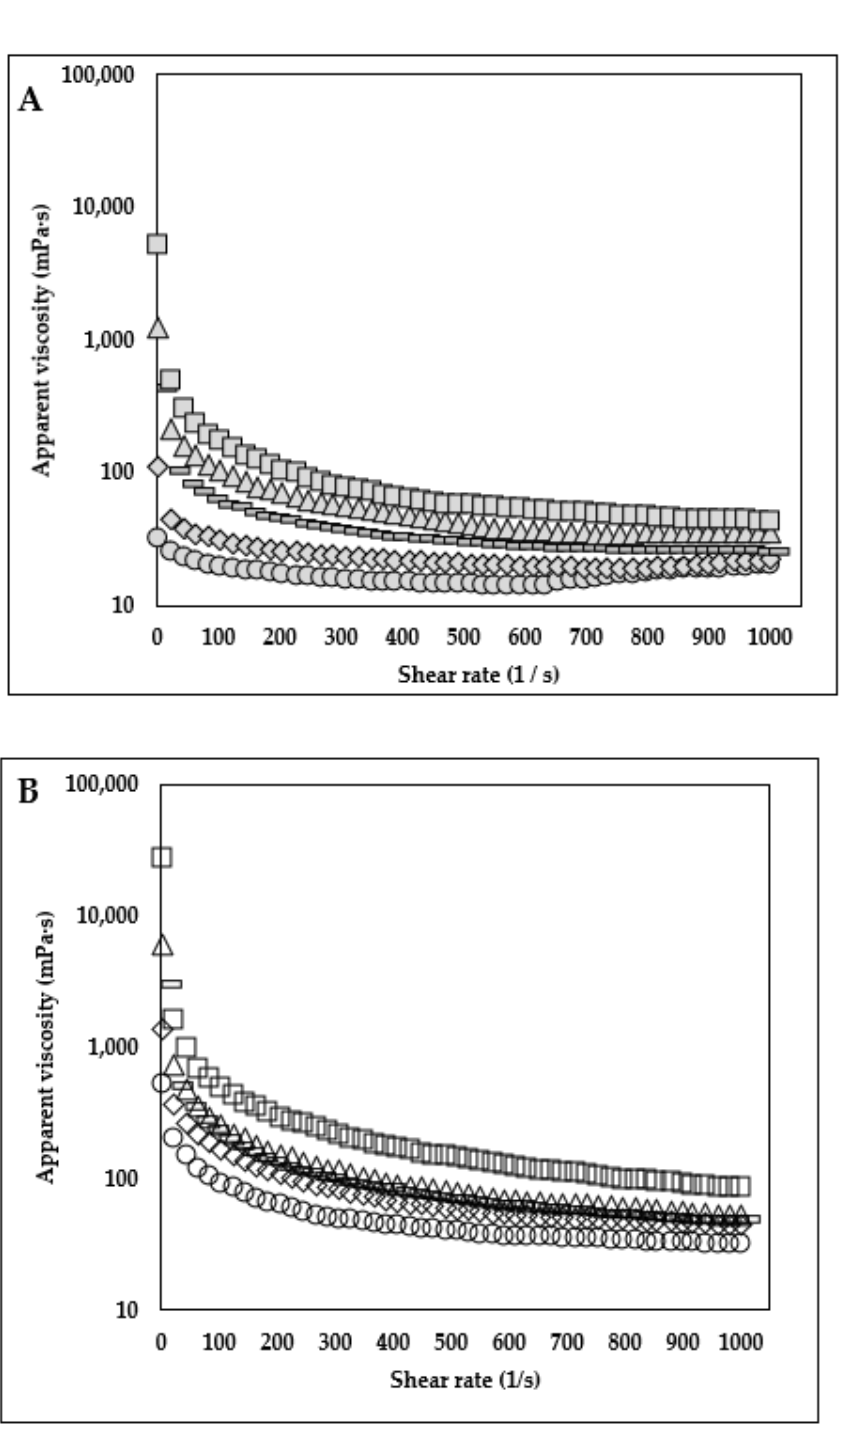
Figure 6. Viscosity profile of skim milk samples treated with different concentrations and ratios of HA:KC. ( A ) 0.1% HA + KC: HA-control (100:0)—( ● ), HA:KC (85:15)—( ♦ ), HA:KC (70:30)—( ▬ ), HA:KC (50:50)—( ▲ ), and KC-control—( ■ ). ( B ) 0.25% HA + KC: HA-control (100:0)—( ○ ), HA:KC (50:50)—( ∆ ), and KC-control—( (cid:3) ). To allow better visual clarity of the graph, the error bars ( n = 3, for the standard error of the mean) are not